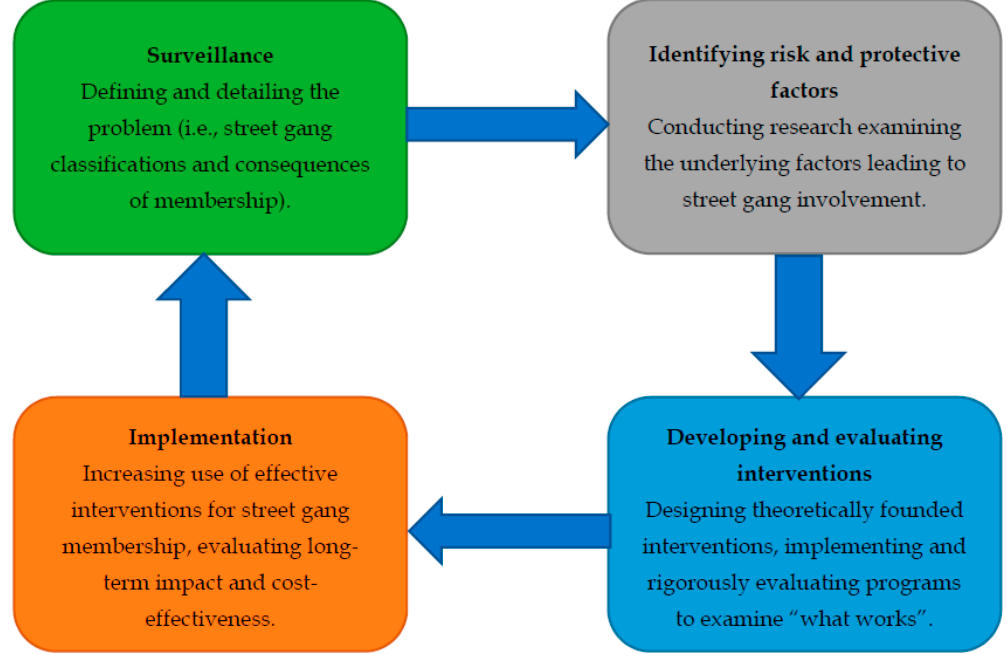
Figure 1. WHO’s public health approach to violence prevention (Krug et al. 2002), adapted for street gang intervention.